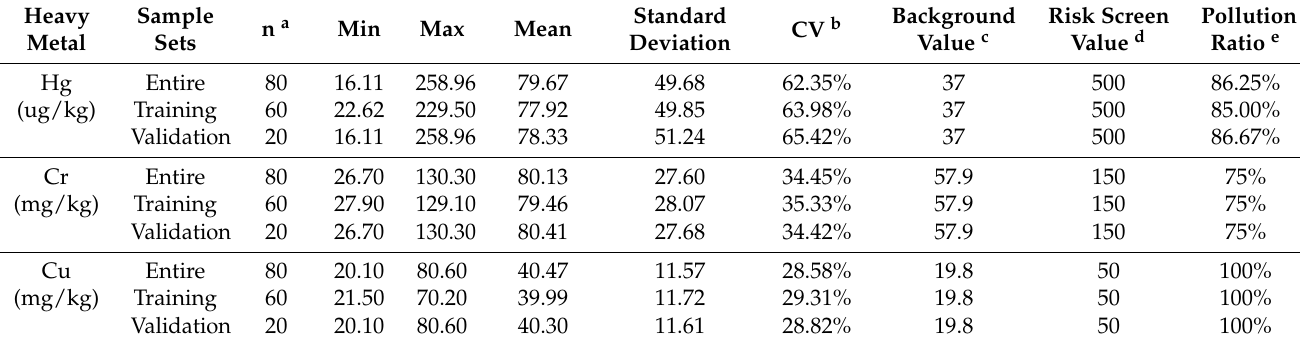
a Sample number. b Coefficient of variation. c The soil background values of Hg, Cr, and Cu in Liaoning Province [68]. d Control standard for soil pollution risk of agricultural lands in China [67]. e Percentage of contaminated samples (the soil background values are set as